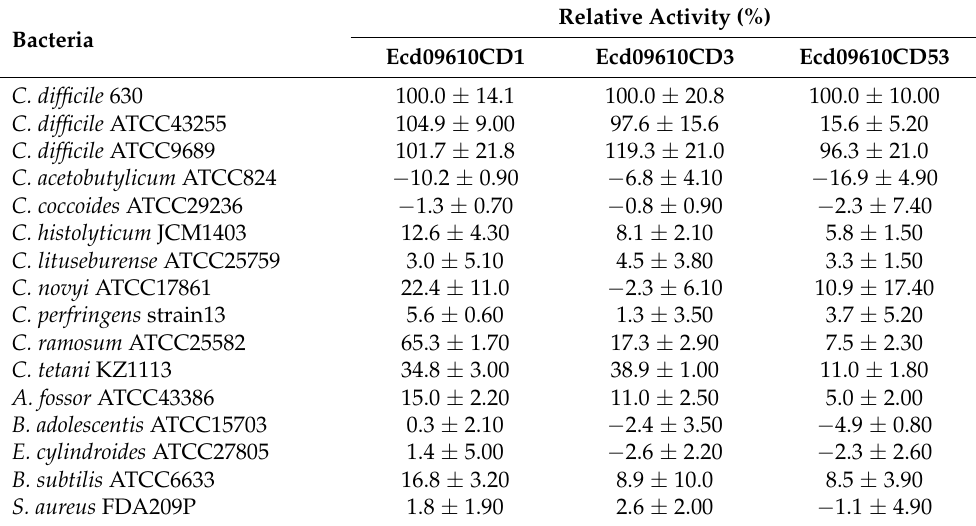
Table 1. Species specificity of Ecd09610 domain variant lytic